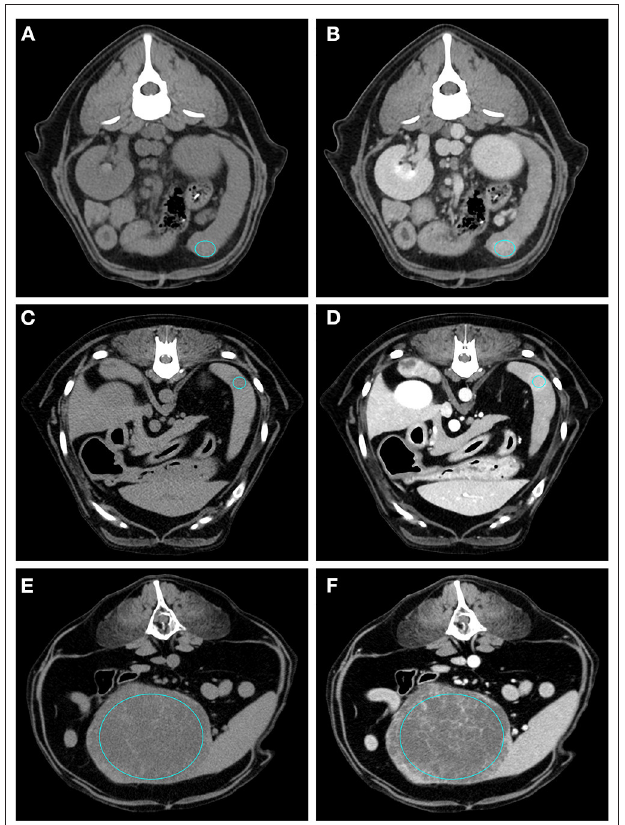
FIGURE 3 | Pre- (A) and post- (B) contrast images of a RCT (diagnosed as lymphoma) showing isoattenuation and hyperenhancement, diffuse enhancement pattern with homogeneous distribution, ill-defined margins, irregular surface, and solid appearance. Pre- (C) and post- (D) contrast images of a RCT (diagnosed as mastocytoma) showing hypoattenuation and hyperenhancement, rim enhancement pattern, with heterogeneous distribution, well-defined margins, regular surface, and solid appearance. Pre- (E) and post- (F) contrast images of a RCT (diagnosed as mesenchymal neoplasia) showing hypoattenuation and hypoenhancement, diffuse enhancement pattern with heterogeneous distribution, well-defined margins, irregular surface, and cyst-like appearance. The ROI is placed inside the lesions.